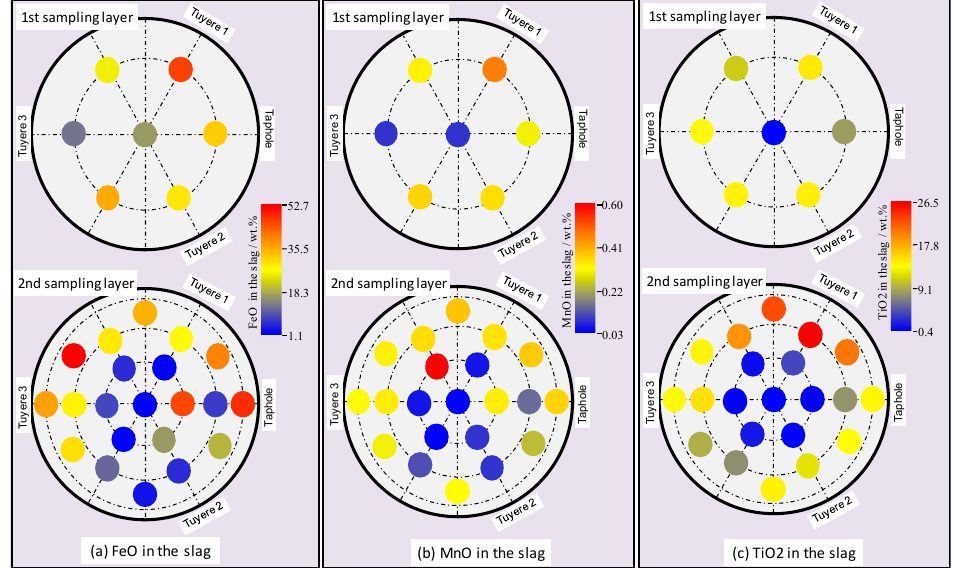
Figure 6. Distribution of selected compounds in the slag samples from the EBF hearth: ( a ) FeO in the slag; ( b ) MnO in the slag; ( c ) TiO 2 in the slag.